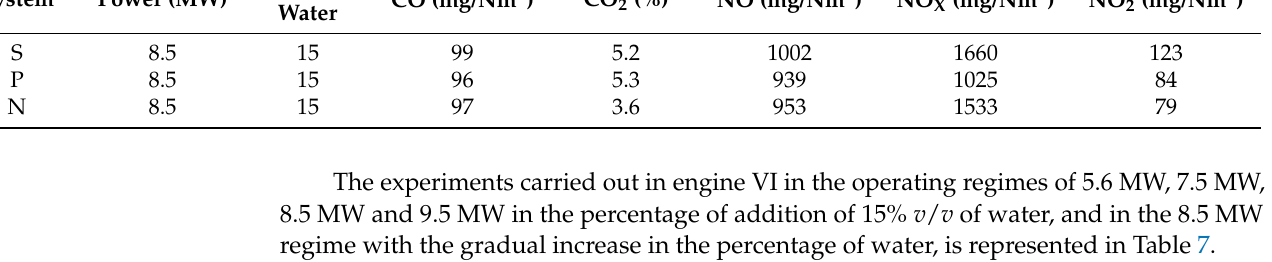
Table 7. Comparison of specific fuel oil consumption in the reference and on S, P, N system.